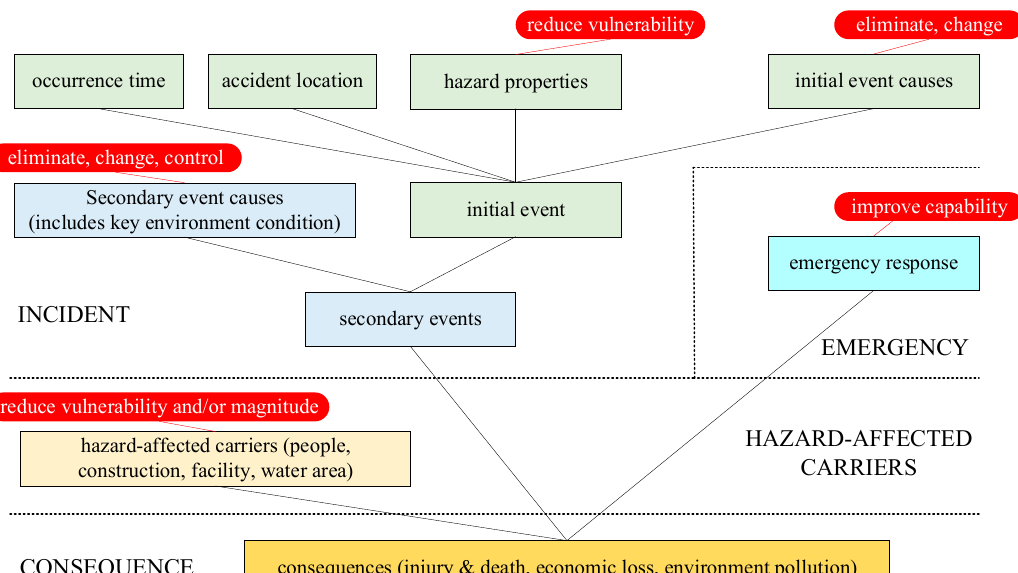
Figure 4. The framework of the BDN model for risk treatment strategy development.